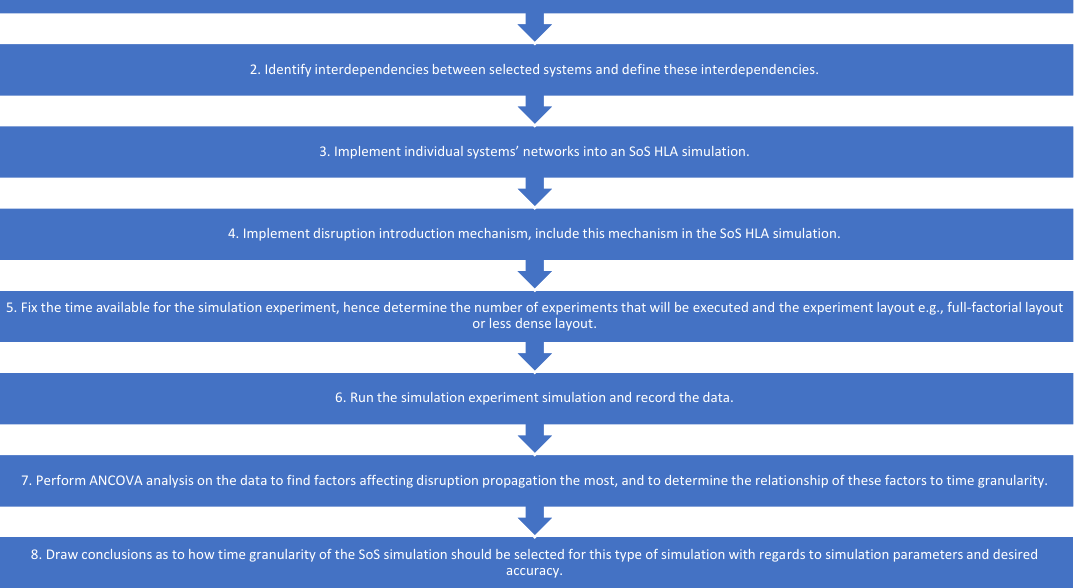
Figure 2. Framework for the analysis of time granularity effects on propagation of disruption in an SoS simulation.